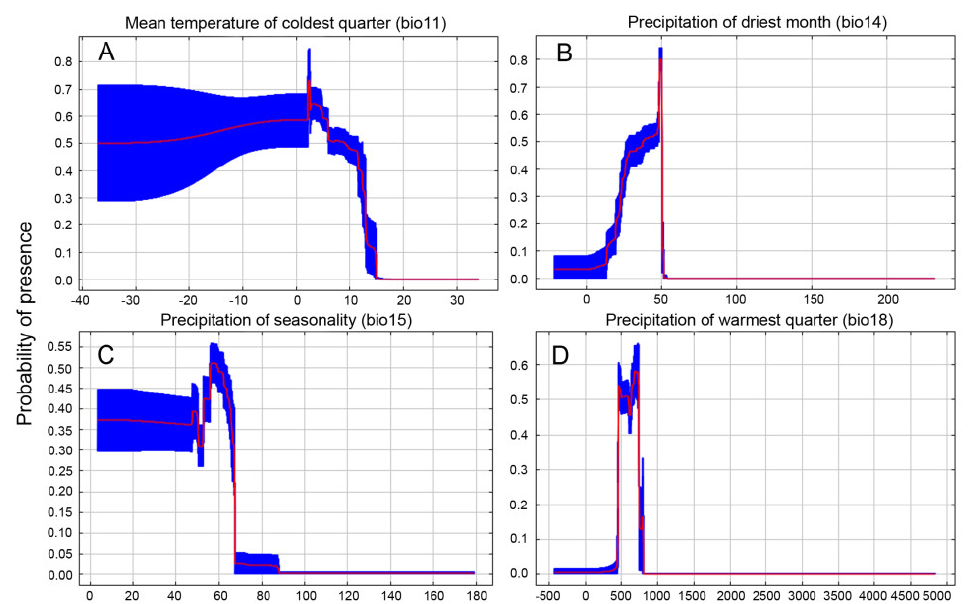
Figure 5. Probability response curves for the main predictor variables of the modeled distribution of A. cordatum based on the MaxEnt algorithm. ( A ) Mean Temperature of Coldest Quarter (bio11), ( B ) Precipitation of Driest Month (bio14), ( C ) Precipitation of Seasonality (bio15), and ( D ) Precipitation of Warmest Quarter (bio18). The red curves represent the mean response of the 100 replicate Maxent runs, and the blue shades represent mean +/− one standard deviation.